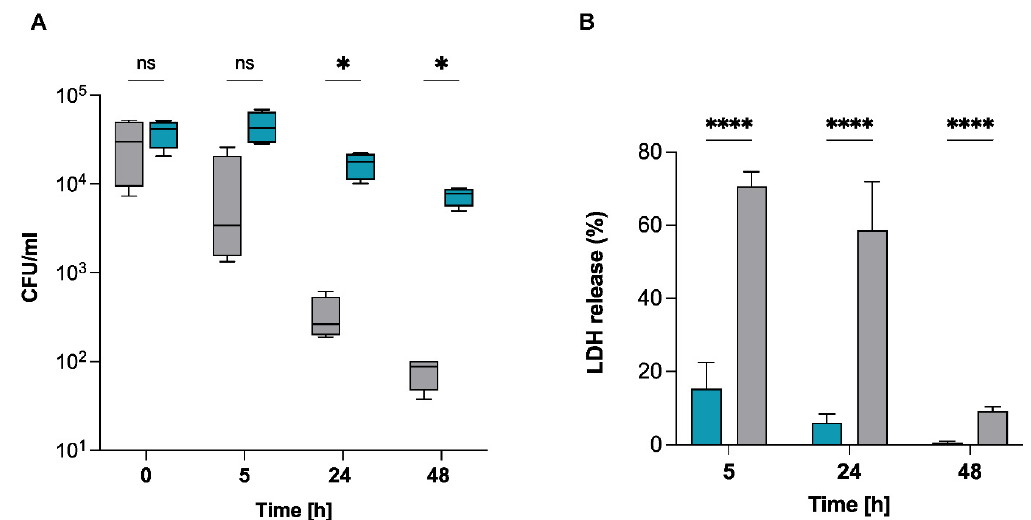
Figure 3. Survival capacity of S. pettenkoferi SP165 in non-professional phagocytes. ( A ) At a MOI of 100, bacteria from S. pettenkoferi SP165 (blue) and S. aureus SA564 (grey) were utilized to infect cells of the keratinocyte cell line HaCaT, and the cells were co-cultured for 90 min. Washing and lysostaphin/gentamicin treatment were used to eliminate extracellular and adhering bacteria, and infected cells were grown for up to 48 h in cell culture media supplemented with lysostaphin. Eukaryotic cells were lysed, and surviving bacteria in lysates were evaluated by counting CFUs at 5, 24, and 48 h after lysostaphin/gentamicin treatment. Percentage survival = (#CFUfinal/#CFUinput) ∗ 100. ( B ) LDH release was measured using the CyQUANT assay kit after HaCaT cells were infected at a MOI of 100 for 5, 24 and 48 h, with the exception that the cells were seeded in a 96-well plate, and the extracellular bacteria were not eliminated. Data are expressed relative to the 100% positive control. Statistical significance was determined by two-way ANOVA test where ns, non-significant; *, p < 0.05; **** p < 0.0001. n = 4 biological repeats.